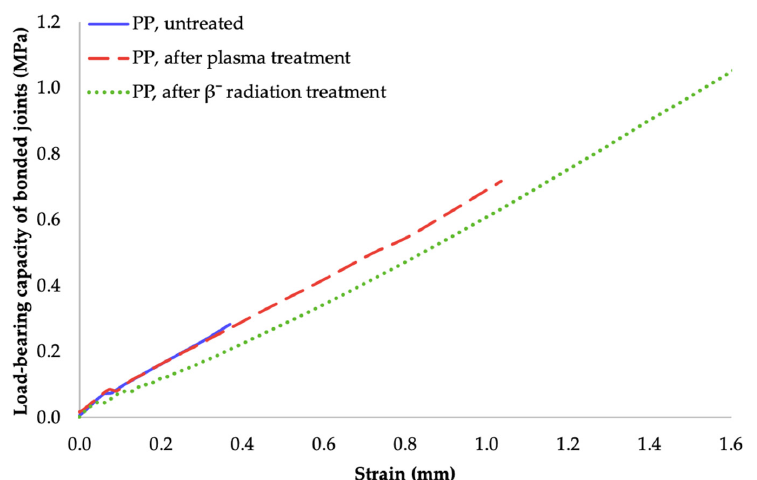
Figure 13. Dependence of bonded-joint load-bearing capacity of adhered joints on strain (two- component epoxide adhesive).